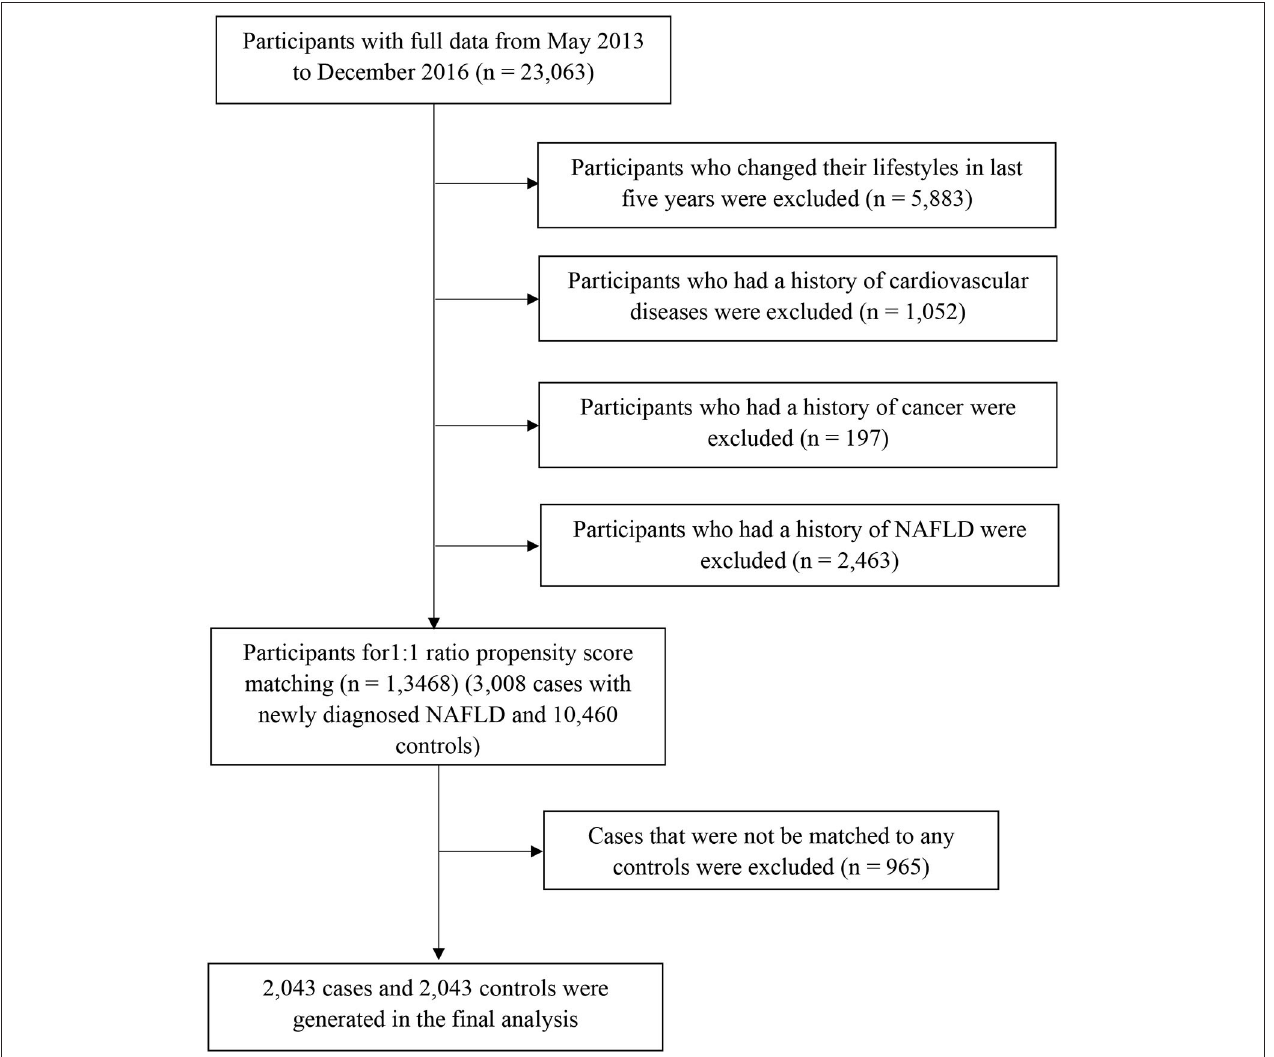
FIGURE 1 | Flow diagram of study participant selection. NAFLD, non-alcoholic fatty liver